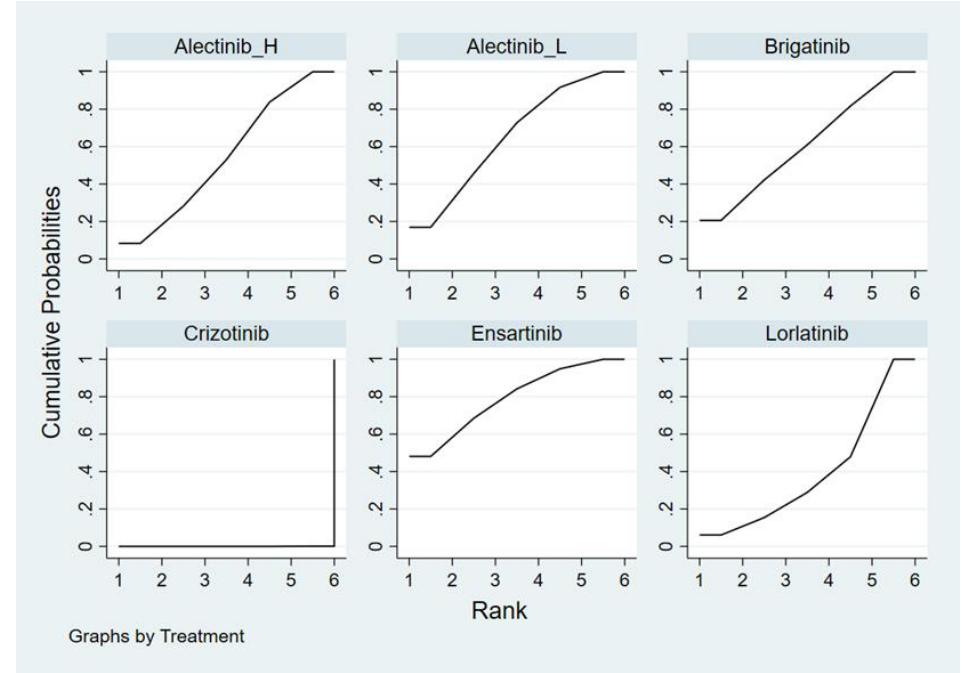
Figure A4 . Cumulative ranking probability for progression free survival (PFS). Figure A4. Cumulative ranking probability for progression free survival